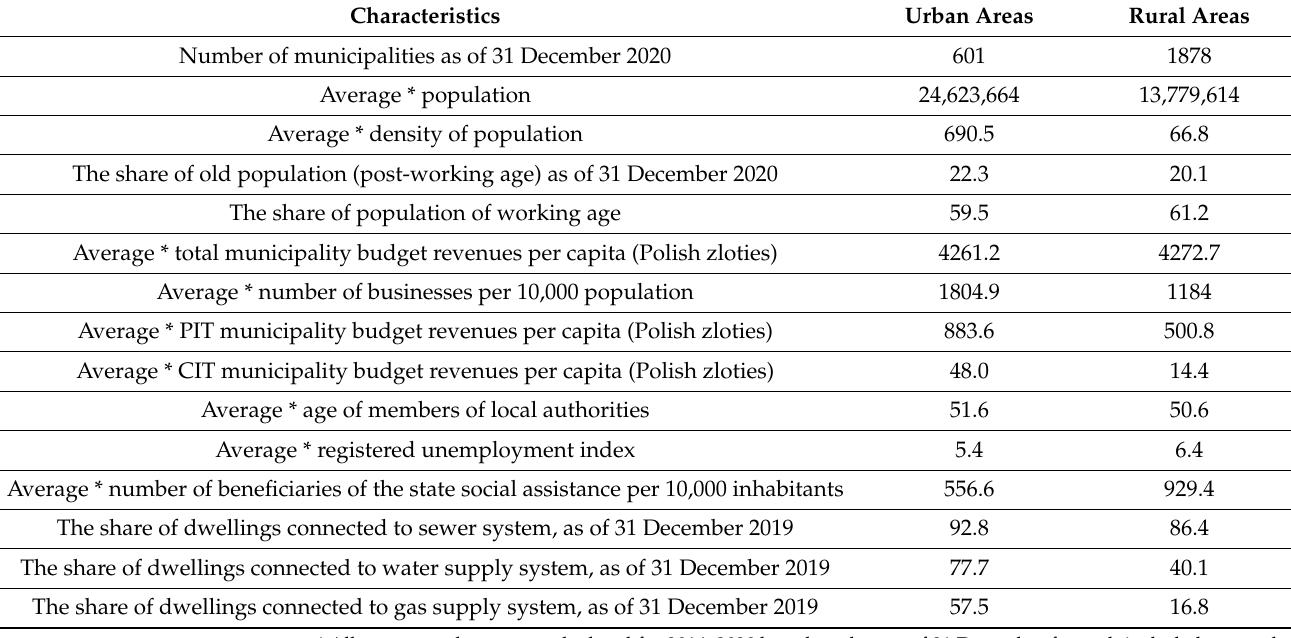
Table 4. Main characteristics of urban and rural areas in